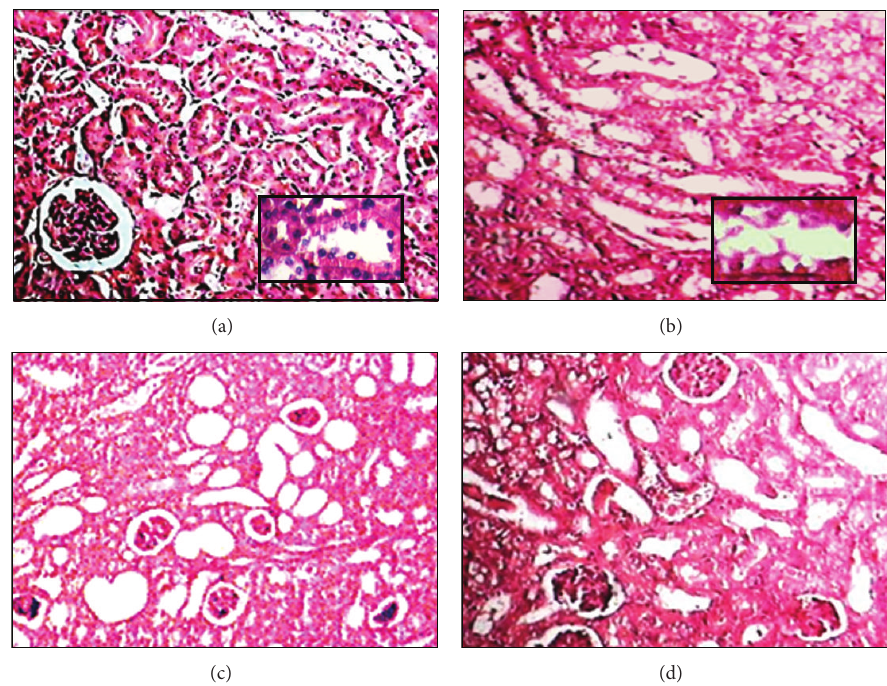
Figure 5: Kidney histological analysis of mice exposed to diphenyl ditelluride 10 𝜇 mol/kg for 7 days. (a) Kidney section of control group showing conserved architecture of cortex with convoluted tubules outlined for a single layer of cuboidal cells and preserved glomeruli (detail 40x). Kidney section of diphenyl ditelluride treated mice showing (b) vacuolar degeneration represented for marked epithelial cells swelling of renal tubules (detail 40x); (c) dilated distal tubules and proximal tubules in different stages of compression; loss of brush border and some tubular cells free in lumen; (d) hypertrophic tubules filled with eosinophilic homogeneous substance (cast proteinaceous) (H&E 10x). The picture is a representation of three independent